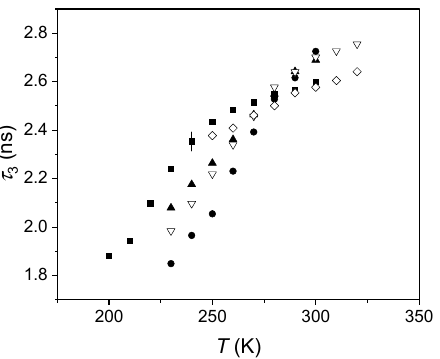
Figure 3. o-Ps lifetime versus the temperature in the investigated elastomers (S1: squares, S2: circles, S3: filled triangles, S4: empty triangles, S5: empty diamonds). Typical uncertainty is shown only for one lifetime for the sake of clarity.